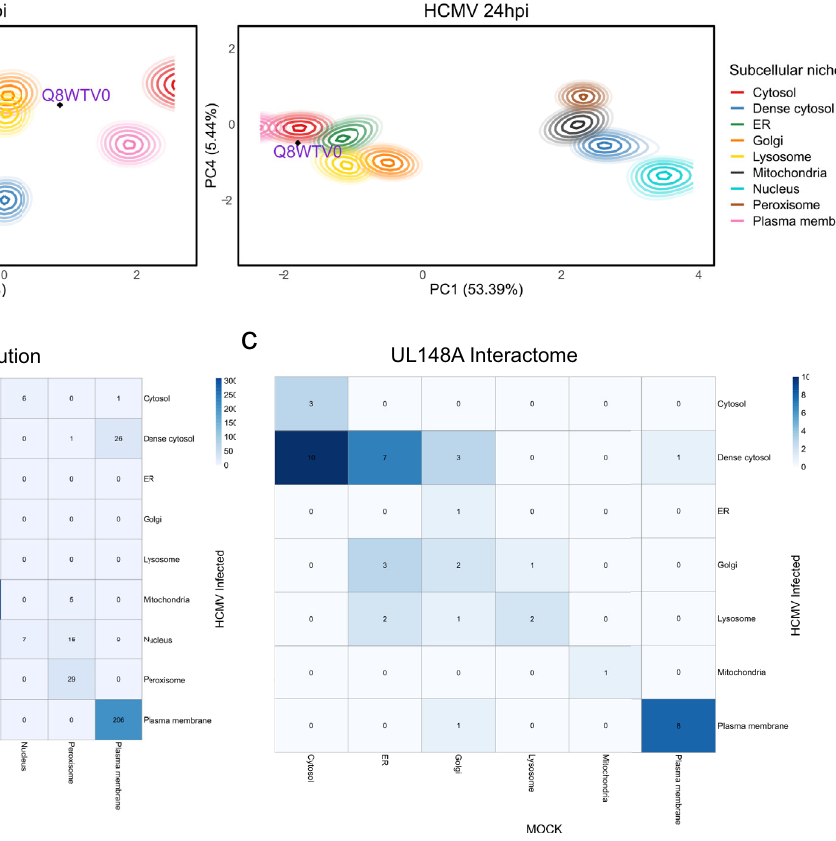
Fig. 6 | BANDLE applied to the HCMV dataset. a PCA plots with (smoothed) localisationprobabilitiesprojectedontothem.Eachcolourrepresentsasubcellular nicheandellipsesrepresentlinesofisoprobability.Theinnerellipsecorrespondsto 0.99andtheproceedline0.95withfurtherlinesdecreasingby0.05eachtime.The relocalisationofSCARB1ishighlightedontheplot. b Thespatialallocationderived